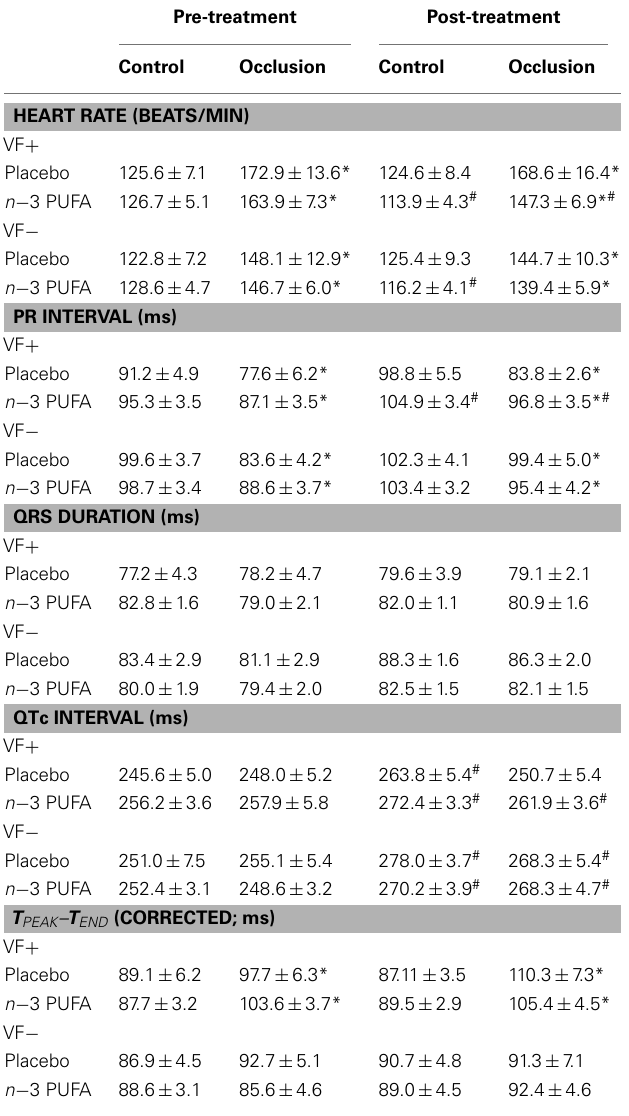
Table 4 | Effect of dietary omega-3 fatty acids on ECG parameters at baseline and during coronary artery occlusion.